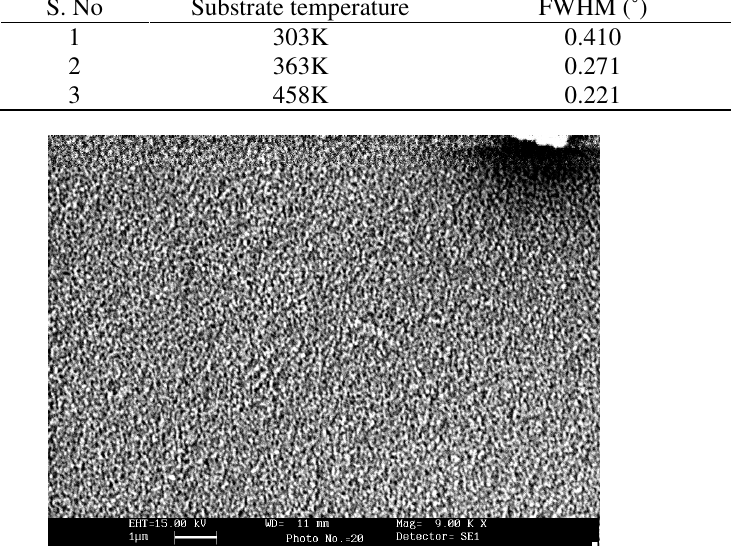
Figure 6 . The scanning electron micrographs of thin film deposited at 303K substrate temperatures.